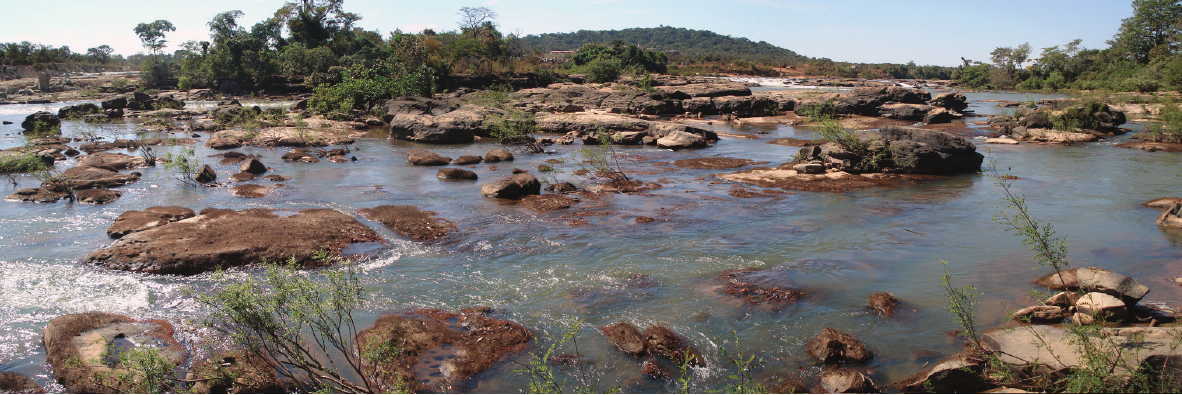
Fig. 7. Rio Culuene, tributary of Xingu river in Brazil, at the type locality of Leporinus villasboasorum . The river stretch herein illustrated is currently dried by the diversion of the river channel due to the construction of the Paranatinga 2 hydroelectric dam. Paratypes. All from Brazil (Xingu basin). ANSP